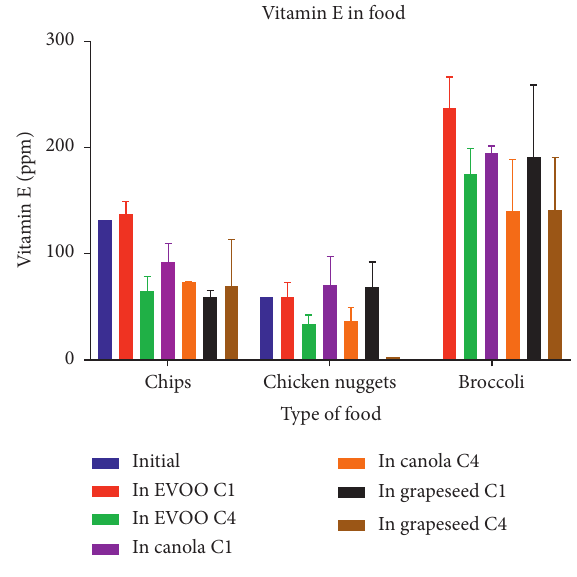
Figure 2: Vitamin E in the food (ppm).